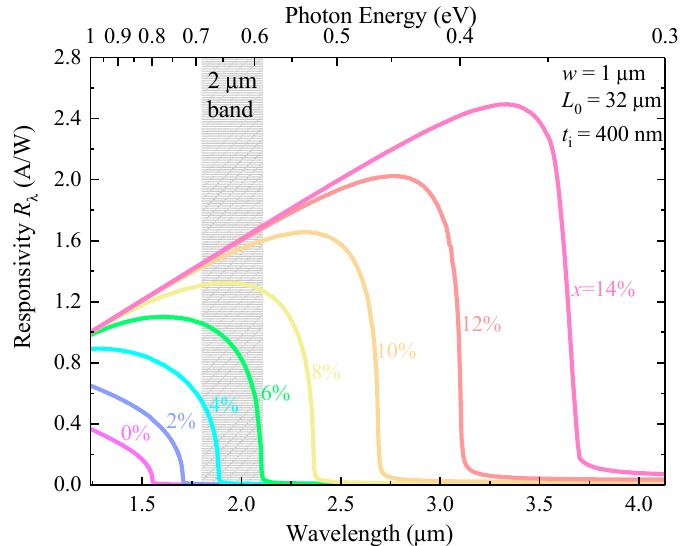
Figure 10. Calculated responsivity spectra of GeSn waveguide photodetectors for different Sn concentrations.